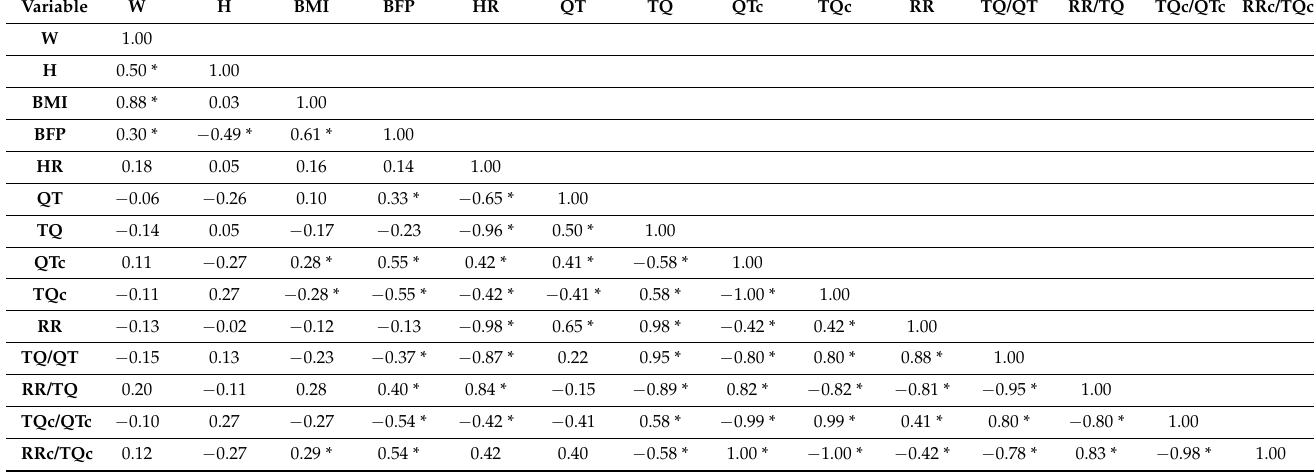
Table 3. Correlation output (Pearson’s correlation coefficient R) between the recorded variables and level of statistical significance p ( n =